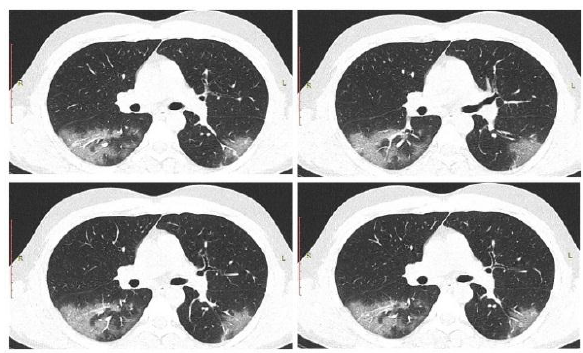
Figure 5. CT CT image of patient 1, first study.